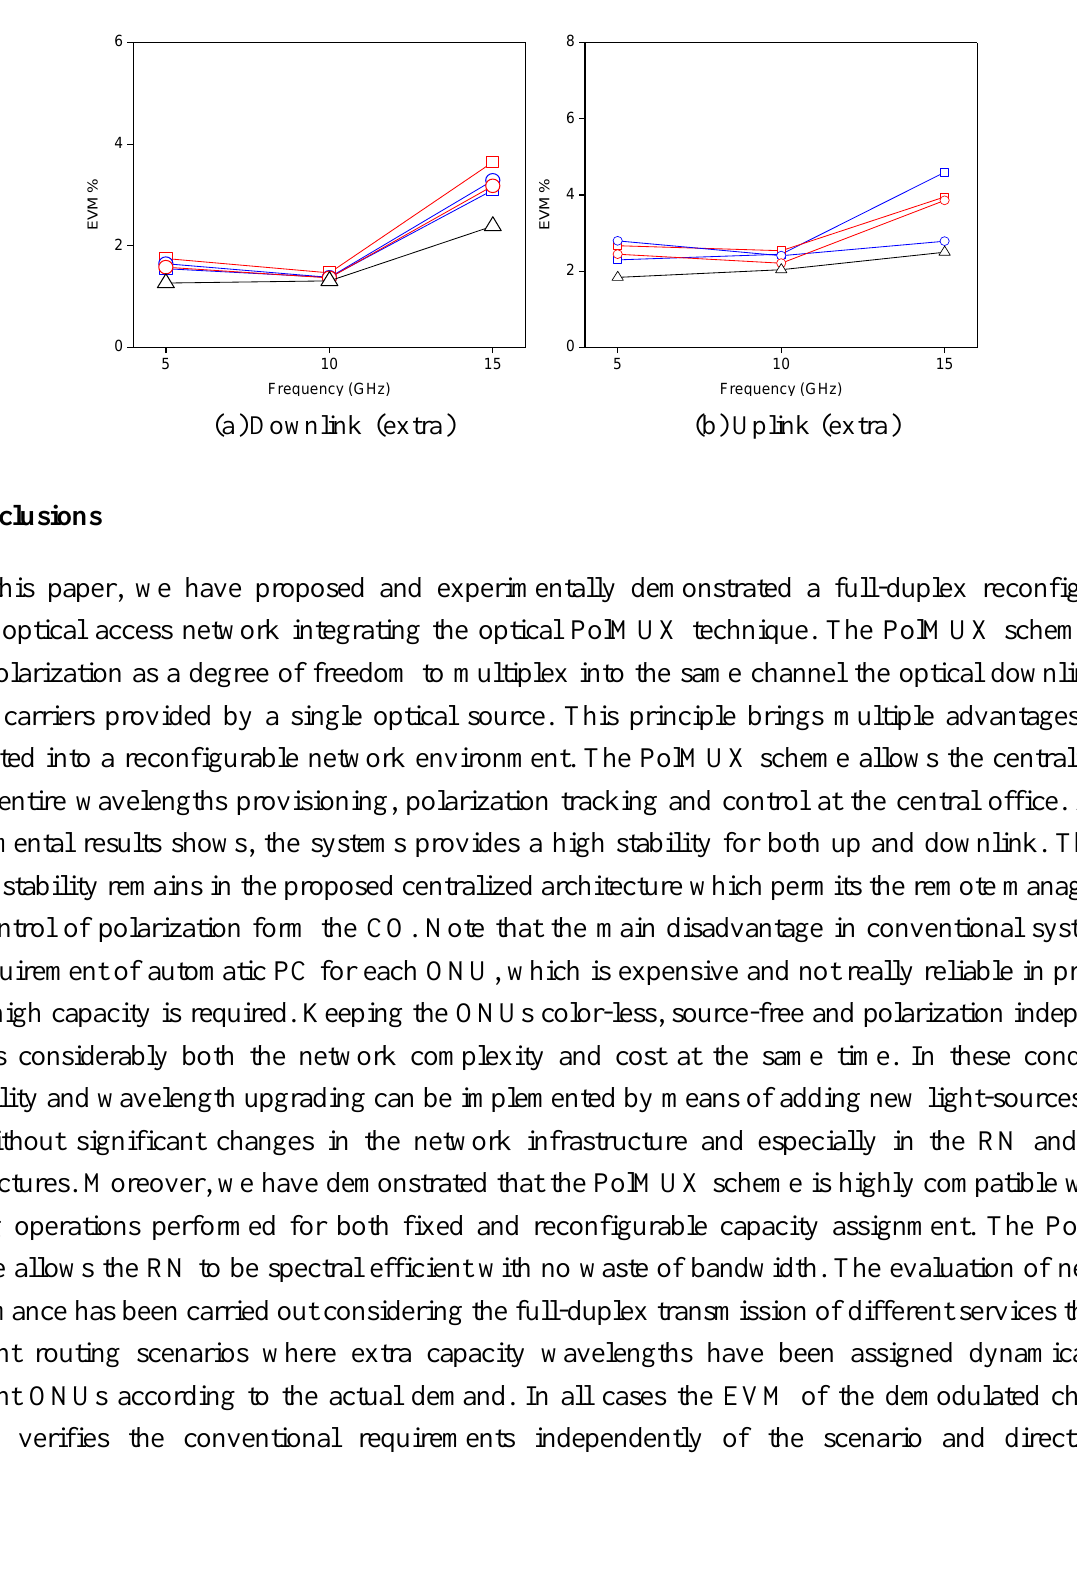
Figure 7. EVM vs. SCM frequency for (a) downlink and (b) uplink transmission in different routing scenarios considering extra channels λ1E [scenario 1 (  ) and 2 (  )] and λ2E [scenario 1 (  ) and 2 (  )]. Optical back-to-back (  ). Note: all fixed capacity wavelengths carry 5 Mb/s QPSK data over 10 GHz SCM